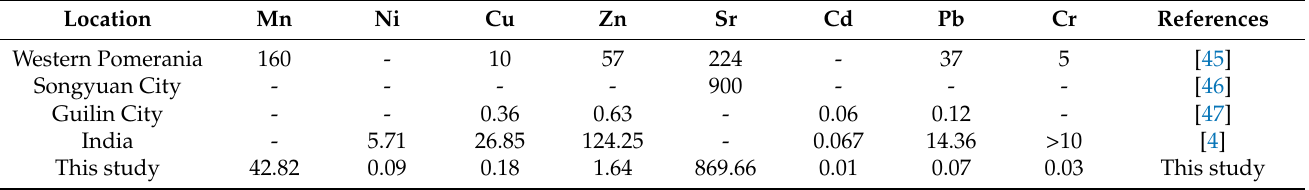
Table 4. Heavy metal concentrations in shallow groundwater in previous studies carried out in world areas.